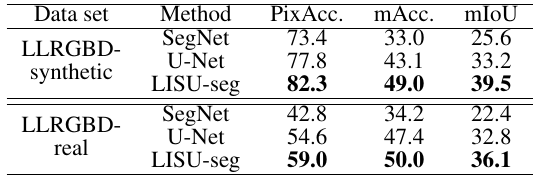
Table 1. Comparison of accuracy of direct segmentation of low-light images.